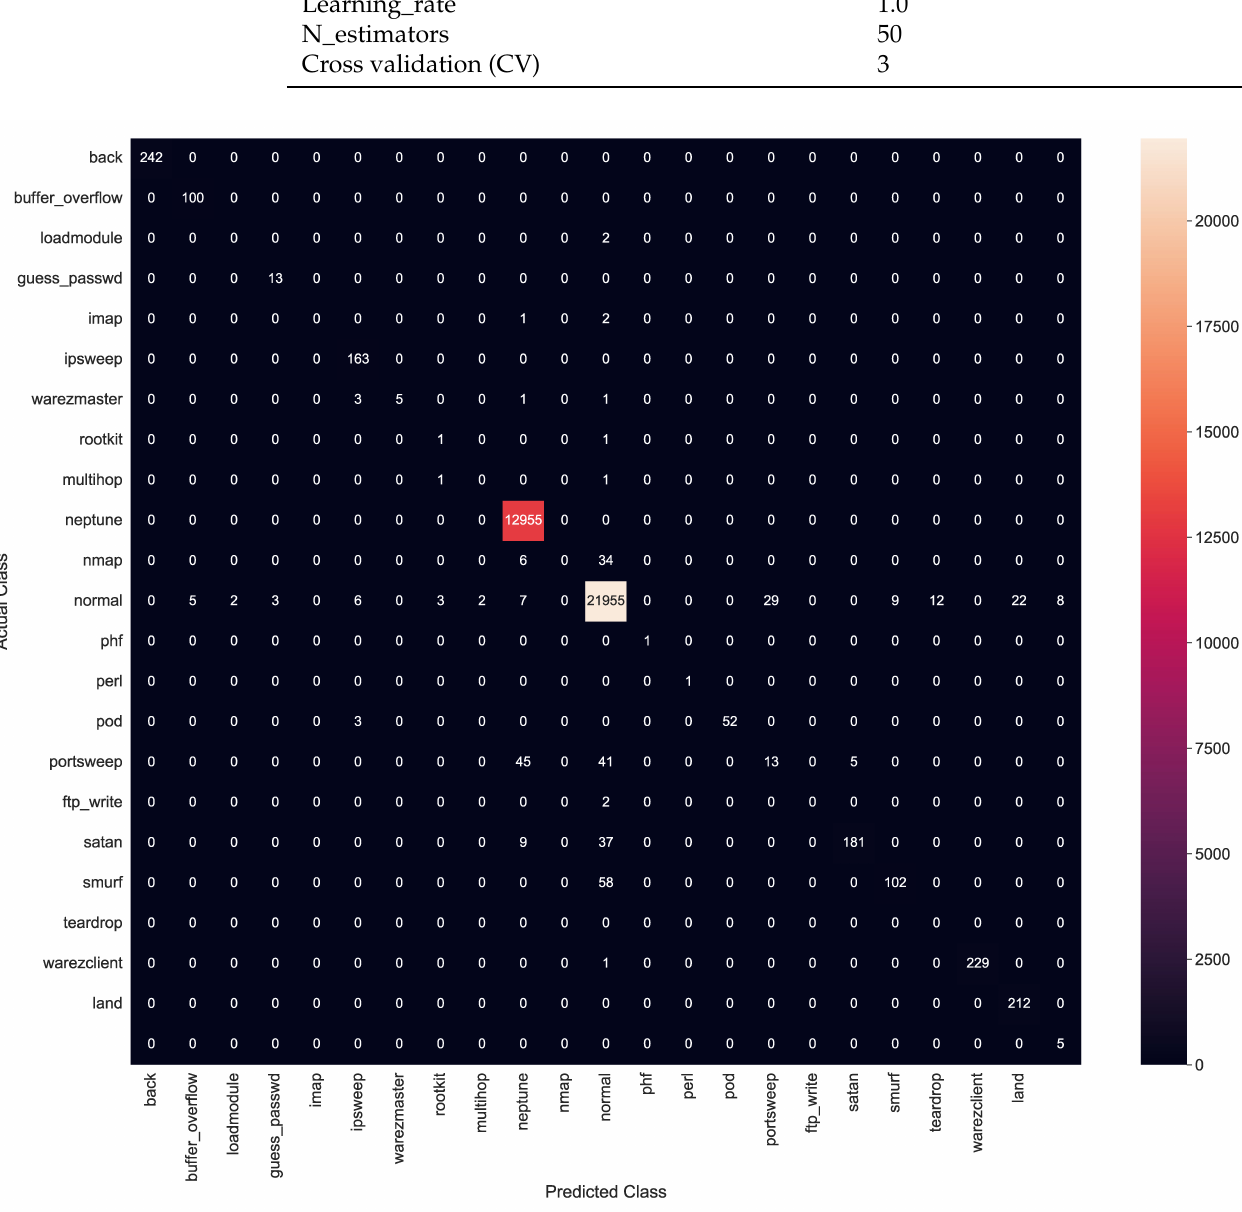
Figure 17. Confusion matrix for AdaBoost